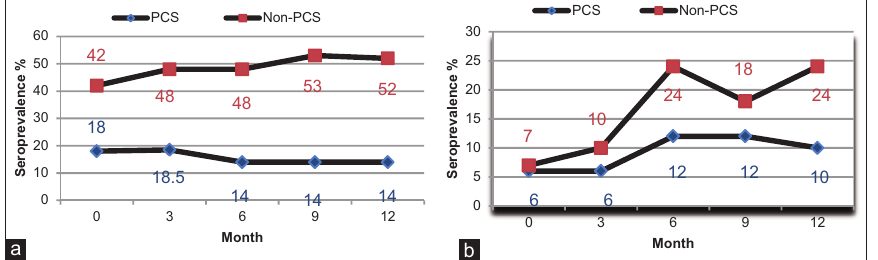
Figure-2: Seroprevalence of 2 parasite infections in confinement and non-confinement pigs during the monitoring period (0-12 months): (a) Cysticerci of Taenia solium ; (b) Toxoplasma gondii